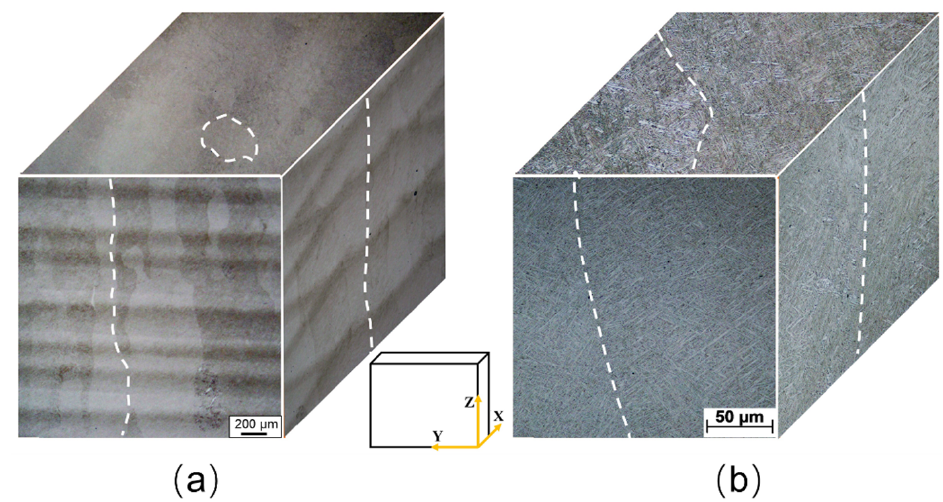
Figure 2. Three-dimensional optical microscopy view of the as-built sample, ( a ) low- and ( b ) high- magnification, which was dominated by columnar β grains.